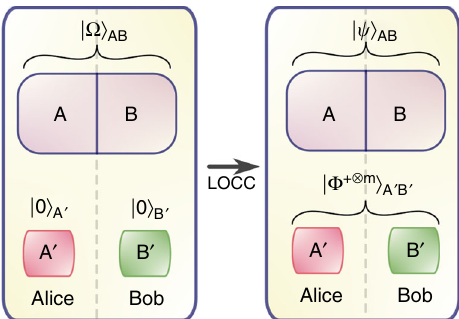
Fig. 1 Energy cost of entanglement extraction: Alice and Bob have access to two parts of a quantum system in an entangled state | Ω 〉 AB with Hamiltonian H AB . Using local operations and classical communication (LOCC), they extract m EPR pairs into their ancillary systems A ′ and B ′ , leaving the physical system in the fi nal state | ψ 〉 AB . Dropping subscripts, the energy cost is then Δ E = 〈 ψ |H| ψ 〉 − 〈 Ω |H| Ω 〉 . Of primary interest to us is the minimal energy cost, where Alice and Bob perform such an extraction protocol outputting m EPR pairs with the lowest value for Δ